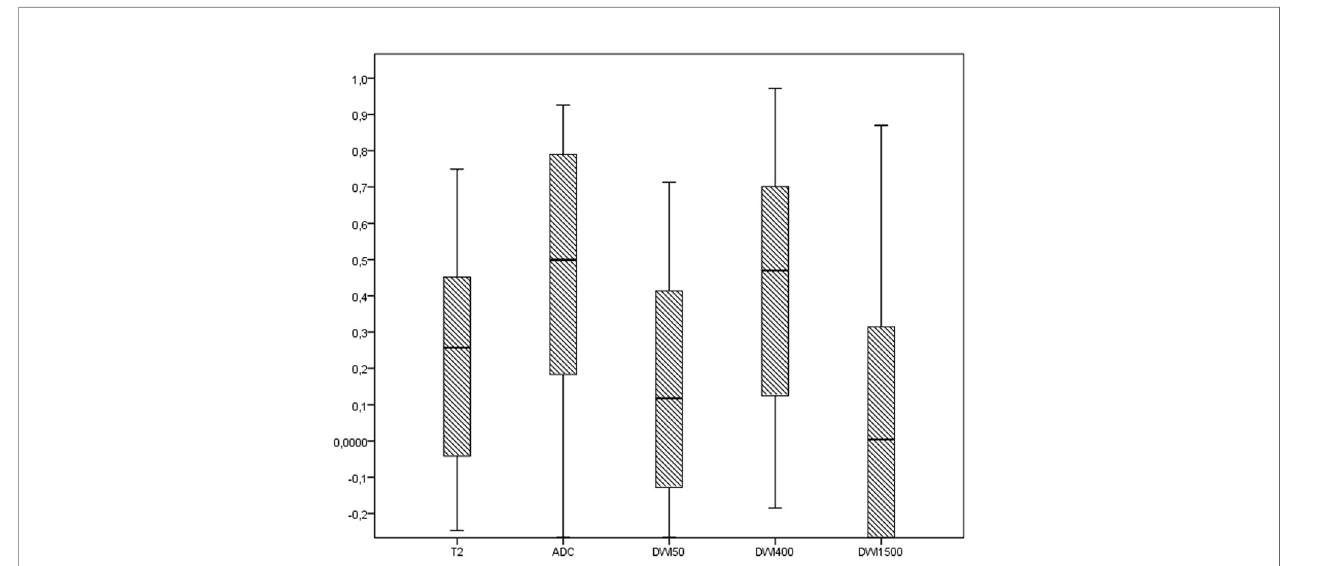
FIGURE 3 | The distribution of ICC of radiomics features across the different MRI sequences.